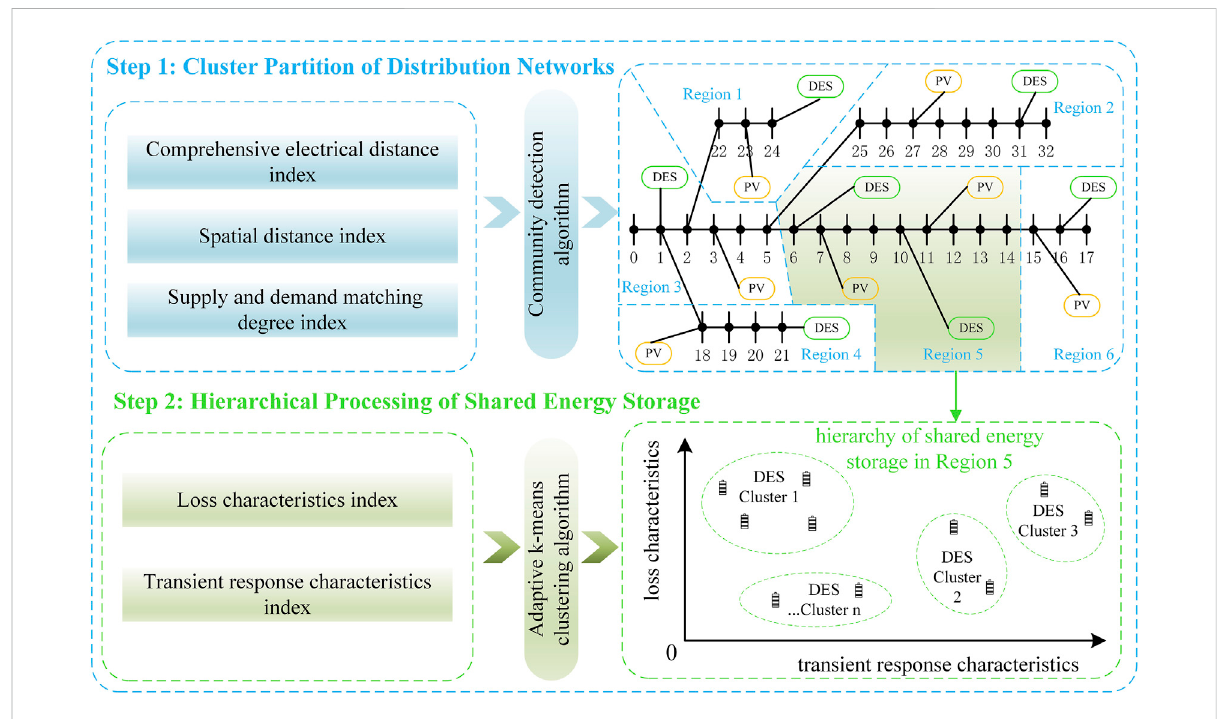
FIGURE 1 Dynamic hierarchical partition schematic